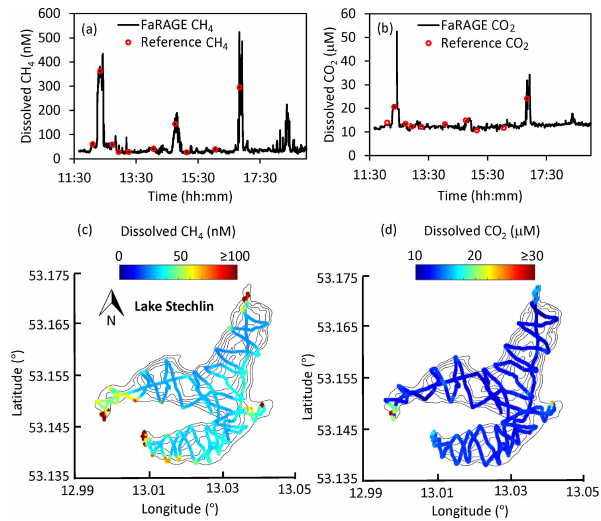
Figure 5. Map of surface dissolved CH 4 concentration at Lake Stechlin. (a, b) Time series of 7h continuous surface water CH 4 and CO 2 measurement on 28 March 2019. The reference headspace measurements are shown as red circles. (c, d) Spatial distribution of surface water CH 4 and CO 2 concentration is given on top of the lake’s bathymetry. Colored symbols show CH 4 and CO 2 concentra- tions according to the color bars. Black lines show the outline of the lake with depth